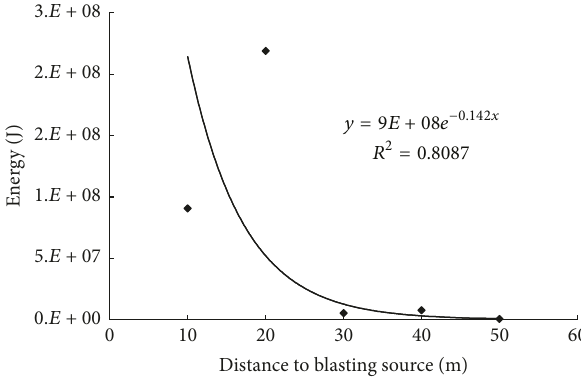
Figure 17: Relationship between energy and distance to blasting source.